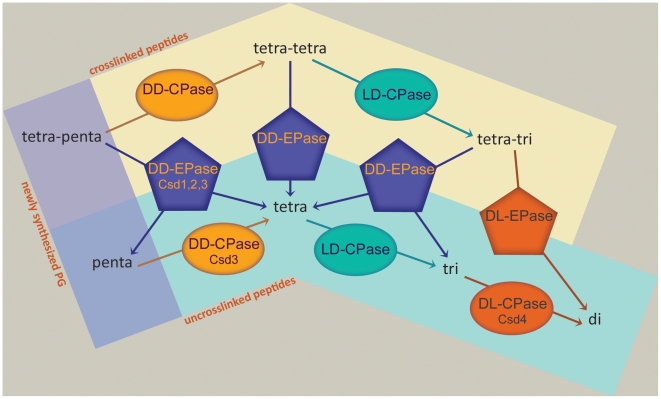
Current understanding of muropeptide modification in H. pylori.This schematic shows peptide modification activities that can generate the muropeptides observed in the H. pylori sacculus. Known H. pylori proteins demonstrated (Csd3, Csd4) or predicted (Csd1, Csd2) to perform these activities are indicated. CPase, carboxypeptidase; EPase, endopeptidase.